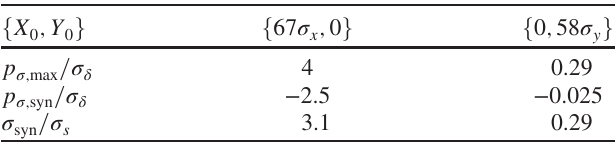
TABLE III. Synchronous point and amplitude of synchrotron oscillations for different transverse initial